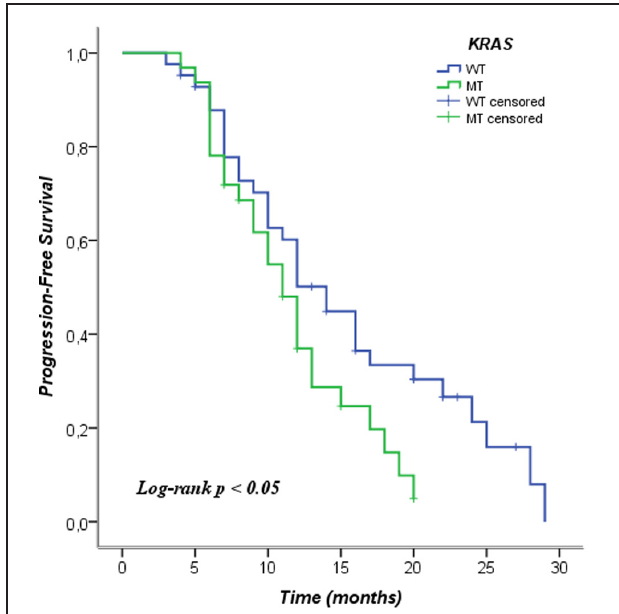
FIGURE 1 | Kaplan–Meier curve of progression-free survival according to mutation status of KRAS . WT, wild type; MT, mutated.